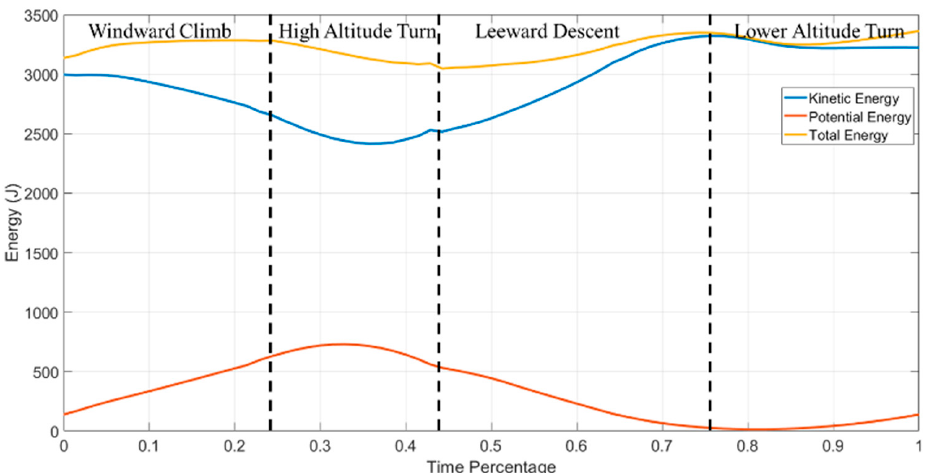
Figure 19. The three energy changes in the one dynamic soaring cycle.